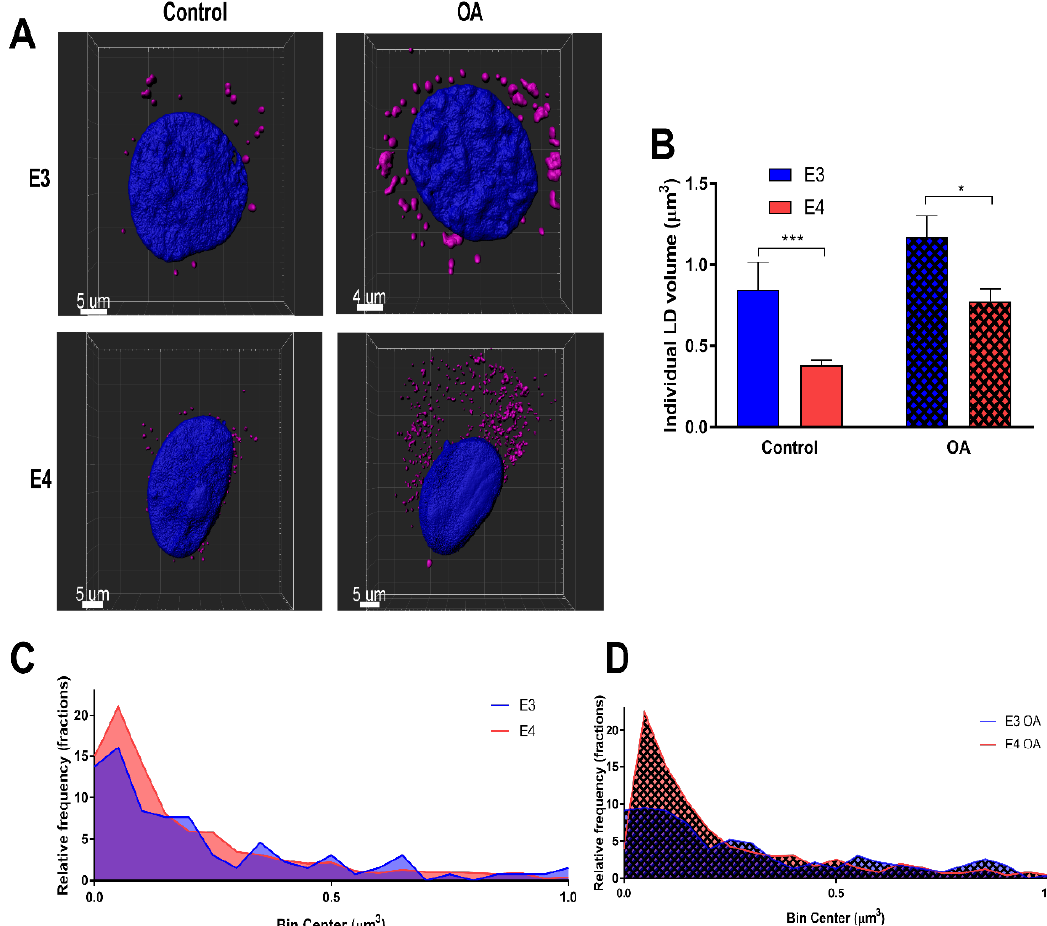
Figure 2. E4 astrocytes have smaller lipid droplets. ( A ) Representative 3D renderings of E3 and E4 astrocytes stained with LipidSpot and DAPI under control and lipid-loaded conditions. ( B ) Individual lipid droplet (LD) volume was quantified under control and lipid-loaded conditions. Values represented are means +/ − SEM. Data were analyzed by unpaired t -test; *** p < 0.001, * p < 0.05. ( C ) Relative frequencies of LD volumes were binned between 0 and 1 µ m 3 under control and ( D ) lipid loaded conditions. Bin size = 0.1 µ m 3 . E3 control LDs ( n = 131); E4 control LDs ( n = 775); E3 OA LDs ( n = 231); E4 OA LDs ( n = 1208).